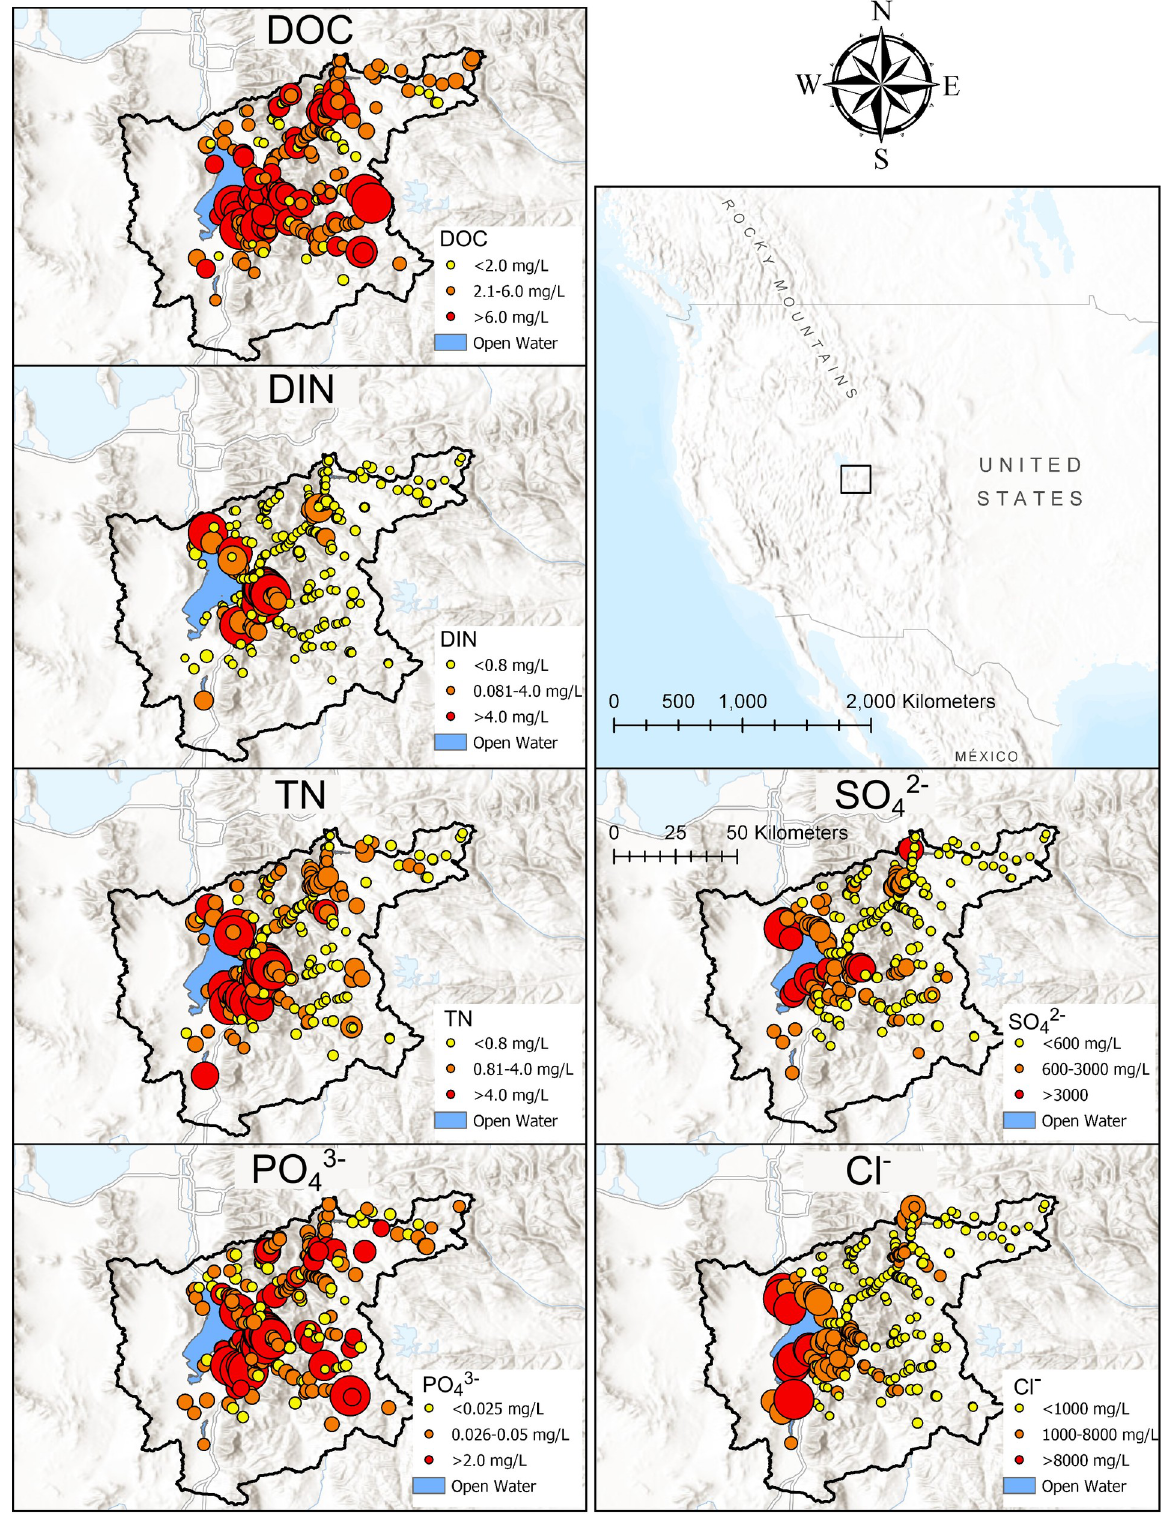
Fig 1. Maps showing the concentration of solutes across the Utah Lake watershed. Samples were collected from the watershed (outlined in black) and averaged across three citizen science synoptic sampling events. Point color represents numeric water quality standards for N and P